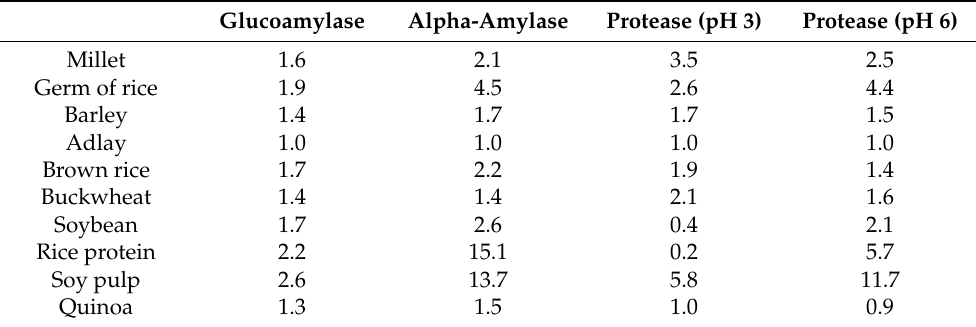
Table 1. Enzyme activity of various substrates’ koji made with Aspergillus oryzae W-52 (for industrial use). Value when enzyme activity of adlay is